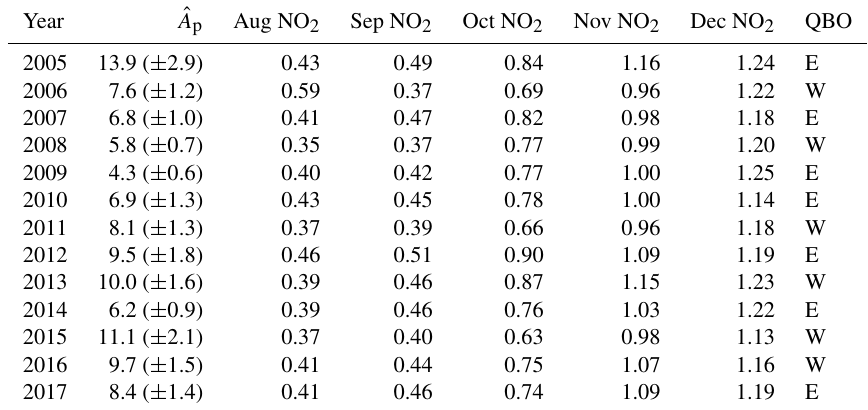
Table 1. The May–August mean A p ( ˆ A p ) ± 2SEM, the polar (60 to 90 ◦ S) August–December monthly mean cos ( latitude ) -weighted zonal mean stratospheric NO 2 column density ( × 10 15 cm − 2 ), and the QBO phase (E represents easterly, and W represents westerly) for each year from 2005 to 2017.